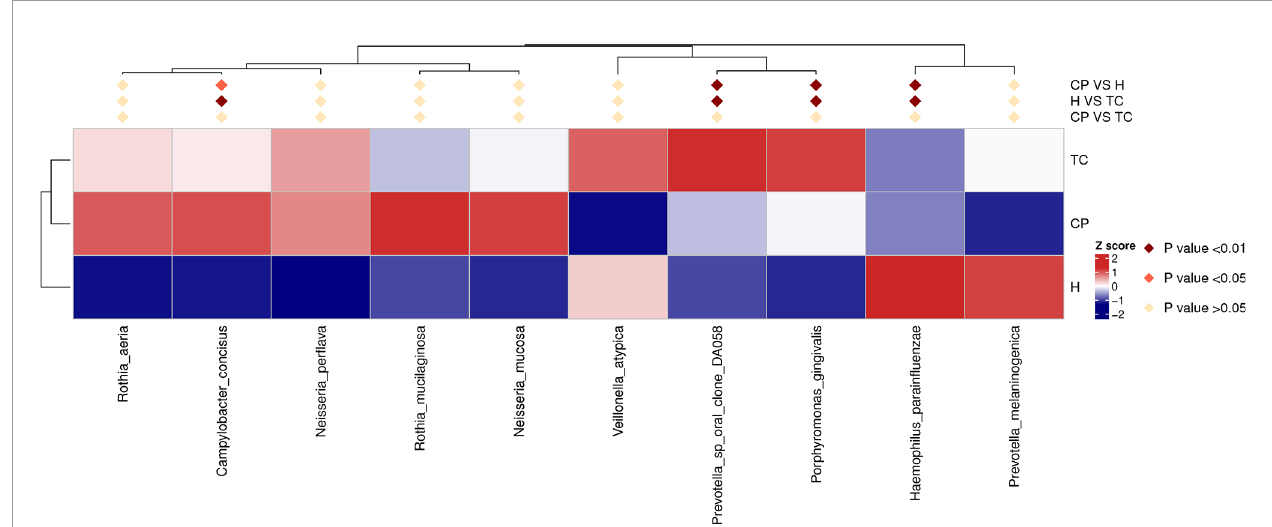
FIGURE 6 | MetaStat analysis; species annotation heatmap. Different colors in the heatmap represent the values obtained after the Z score of the relative content of differential metabolites is standardized, re fl ecting the level of their relative content (red represents high content, and blue represents low